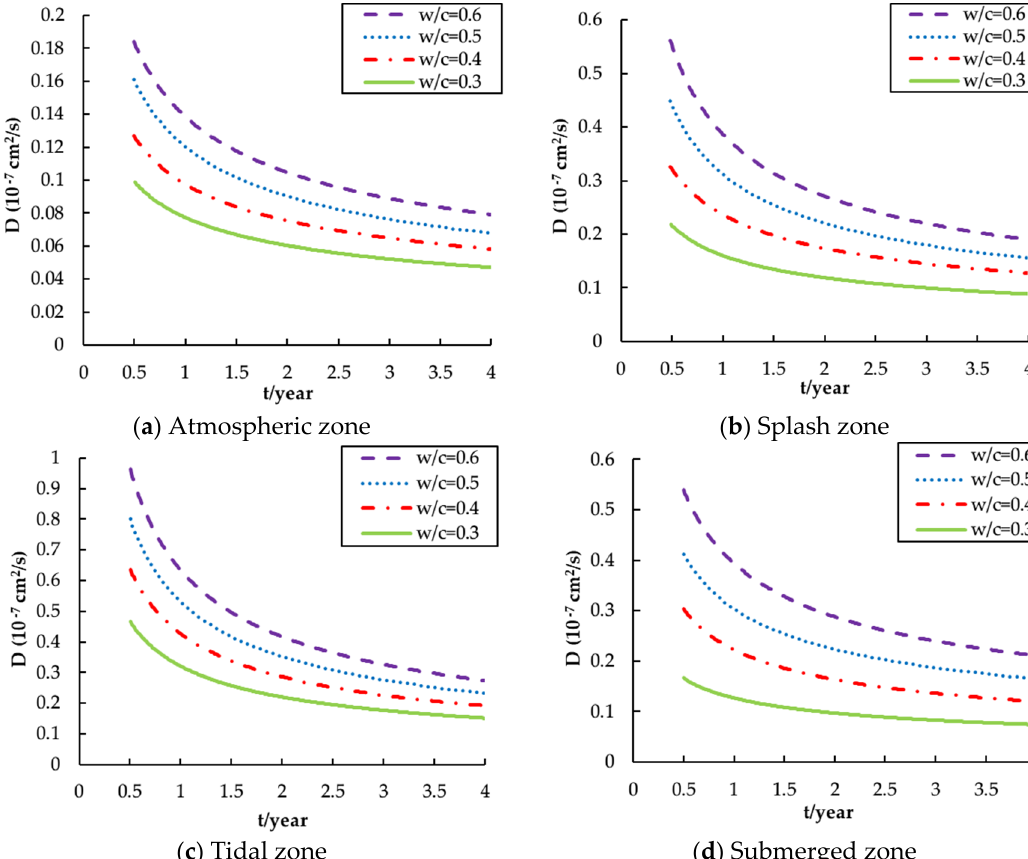
Figure 2. Influence of 𝑤/𝑐 ratio on chloride diffusion coefficient versus time for different zones: ( a ) Atmospheric zone; ( b ) Splash zone; ( c ) Tidal zone; ( d ) Submerged zone.